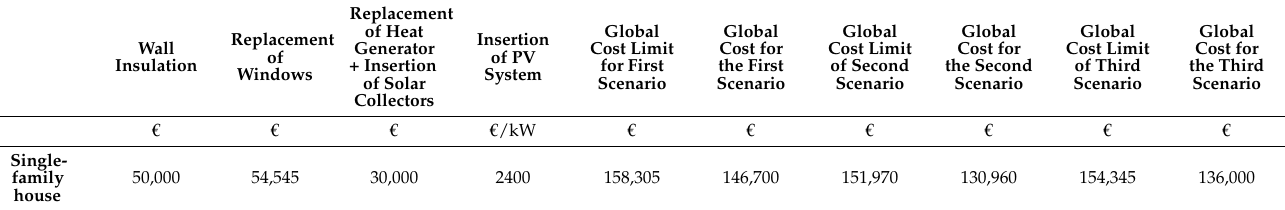
Table 10. Costs and cost